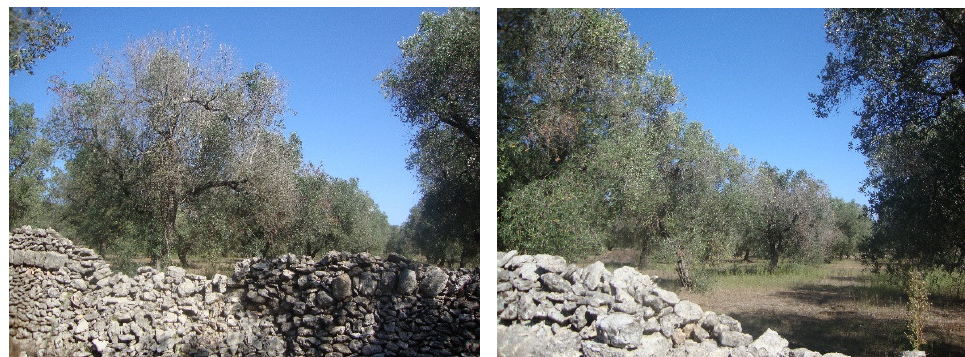
Figure 11. The olive cultivar Leccino is retained resistant to Xylella fastidiosa subsp. pauca , but there are examples of severe OQDS of Leccino trees in the entire infected area of Salento. Two Leccino olive groves nearby Otranto that show clear symptoms of OQDS (Lecce province).